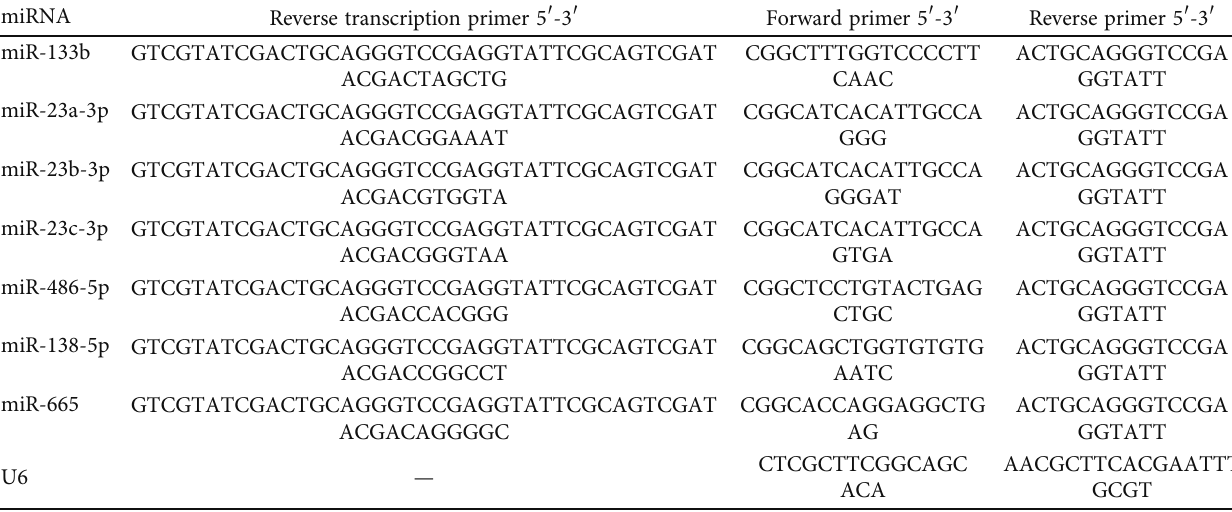
Table 2: Primers used for miRNA expression